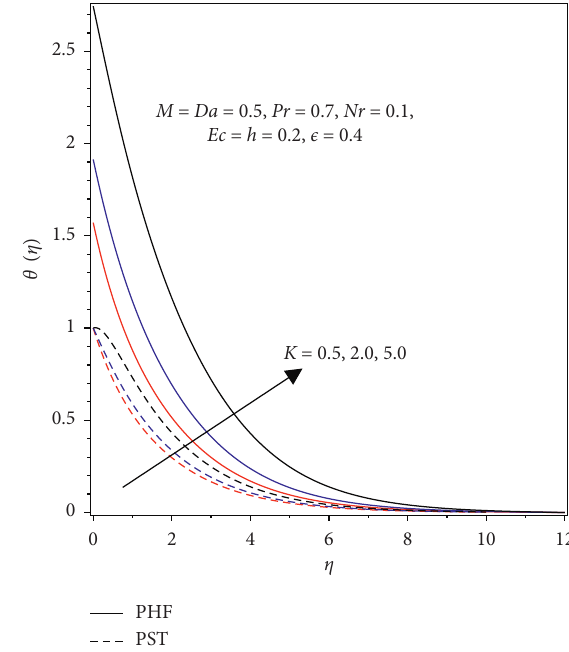
Figure 6: Reaction of thermal field for variation in material pa- rameter K .